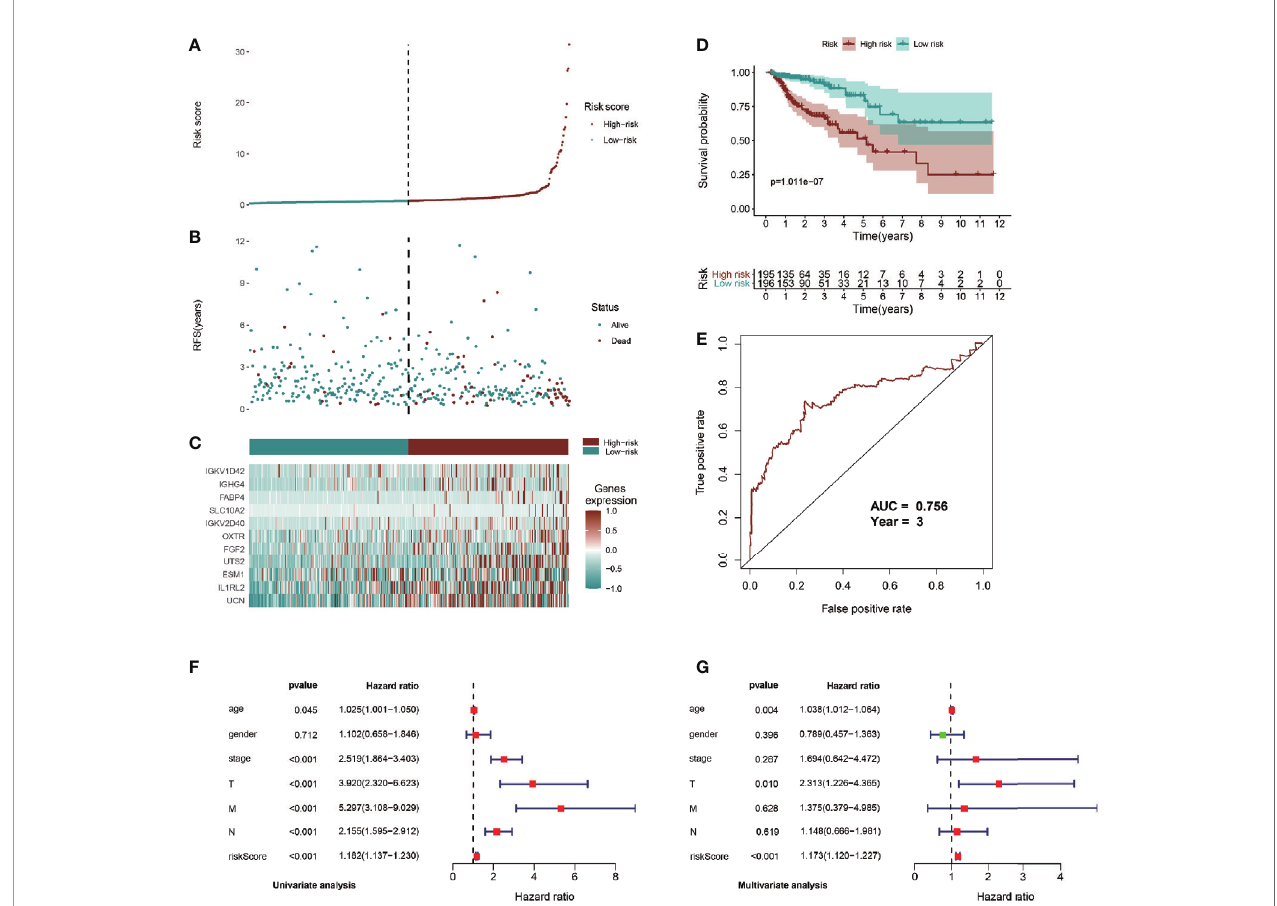
FIGURE 6 | Identi fi cation, construction, and validation of the TII prognostic model system in CRC. (A, B) Patient survival data in the two risk groups. (C) Heatmap plot showing differences in levels of identi fi ed hub immune signature between high-risk and low-risk groups. (D) Kaplan-Meier curves of prognostic signature for CRC patients. (E) 3-year ROC curves for prognostic predictors. Univariate (F) and multivariate (G) Cox regression analyses were conducted to assess the immune-related signatures and clinic characteristics using Forest